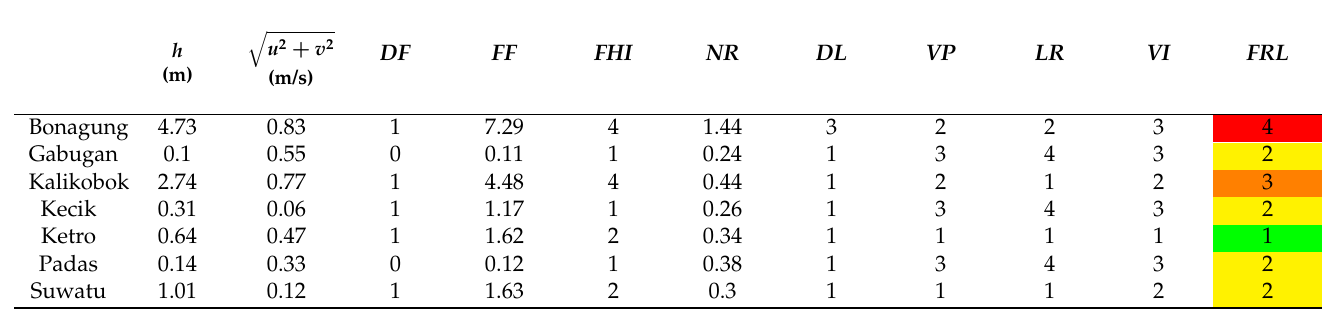
Table 10. Computation for the value of FRL